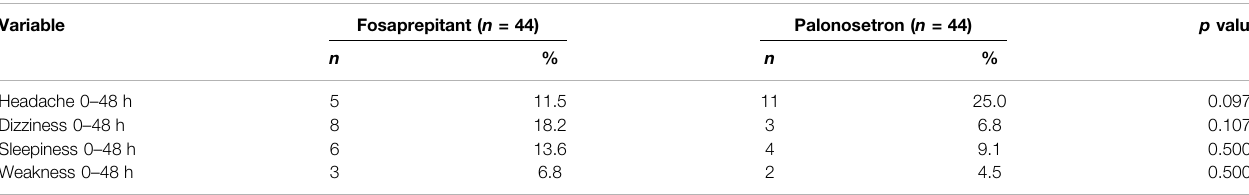
Chi-square or Fisher ’ s exact